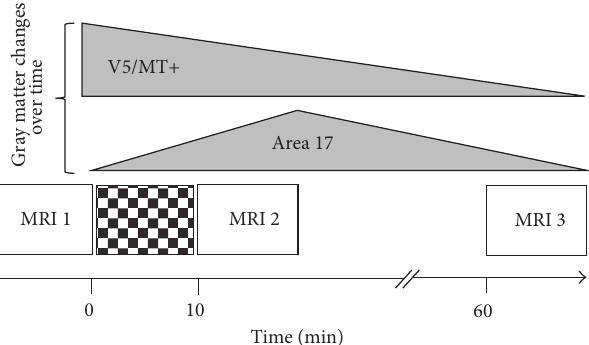
Figure 1: Study design and time course of gray matter changes. Schematicillustrationofstudydesignandtimecourseofgraymatter alterations. Looking 10 minutes at a flickering checkerboard leads to distinct changes of the cerebral gray matter detected by